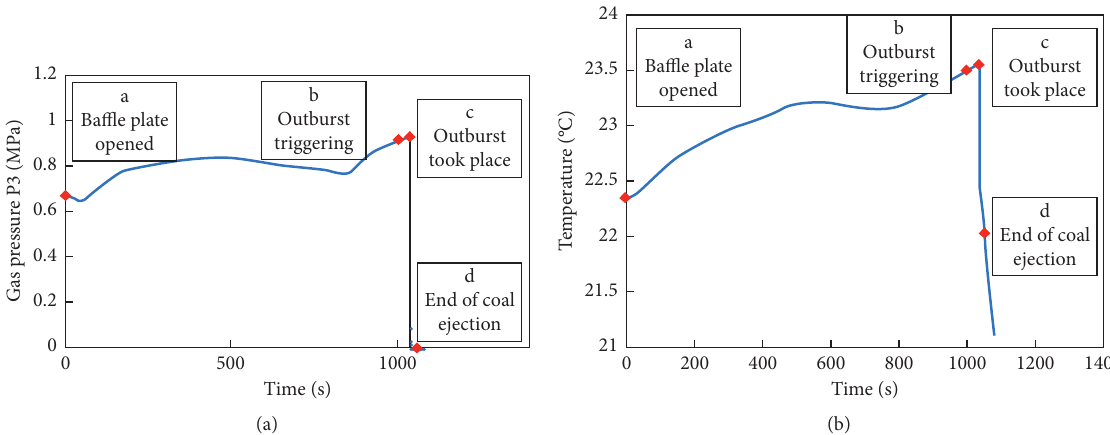
Figure 8: Gas pressure (a) and temperature (b) change curves during the delay outburst caused by gas accumulation ahead of the work face.